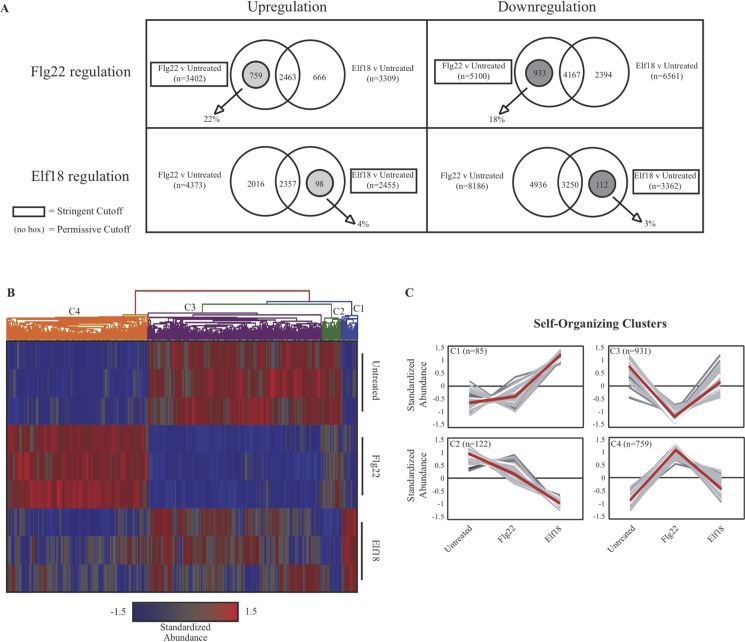
Identification of genes differentially regulated between flg22 and elf18 in wild-type plants.A, After initial analysis (see methods), lists of genes differentially regulated between flg22 and elf18 were assembled. Upregulated (red) and downregulated (blue) genes were determined separately. Flg22-regulated genes not differentially regulated by elf18 in these experiments were defined as those that displayed statistically significant differences in mRNA abundance after treatment with flg22 versus untreated (FDR < 0.05, fold-change > 1.3 or < -1.3), which did not display statistically significant difference in mRNA abundance after treatment with elf18 versus untreated even using more permissive cutoff values (p < 0.05, fold-change > 1.0 or <-1.0). The reciprocal calculations were used to determine elf18-regulated genes not differentially regulated by flg22 in these experiments. B, Hierarchical clustering of transcript abundance for MAMP-regulated genes identified in A as exhibiting differential regulation by only one of the two studied MAMPs (A, n = 1897). Each column represents a single gene and each row a single treatment (all treatments replicated three times); gene abundances standardized to mean = 0, standard deviation = 1.0; red = more abundant, blue = less abundant. Clustering was performed by calculating Euclidean distances on columns, using average linkage scores. C, Average transcript abundance (y-axis) for each treatment (x-axis), for each gene within the designated color-coded clusters shown at the top of A. Red lines denote overall mean mRNA abundance for all genes within the cluster, grayscale lines represent each individual gene within the cluster.